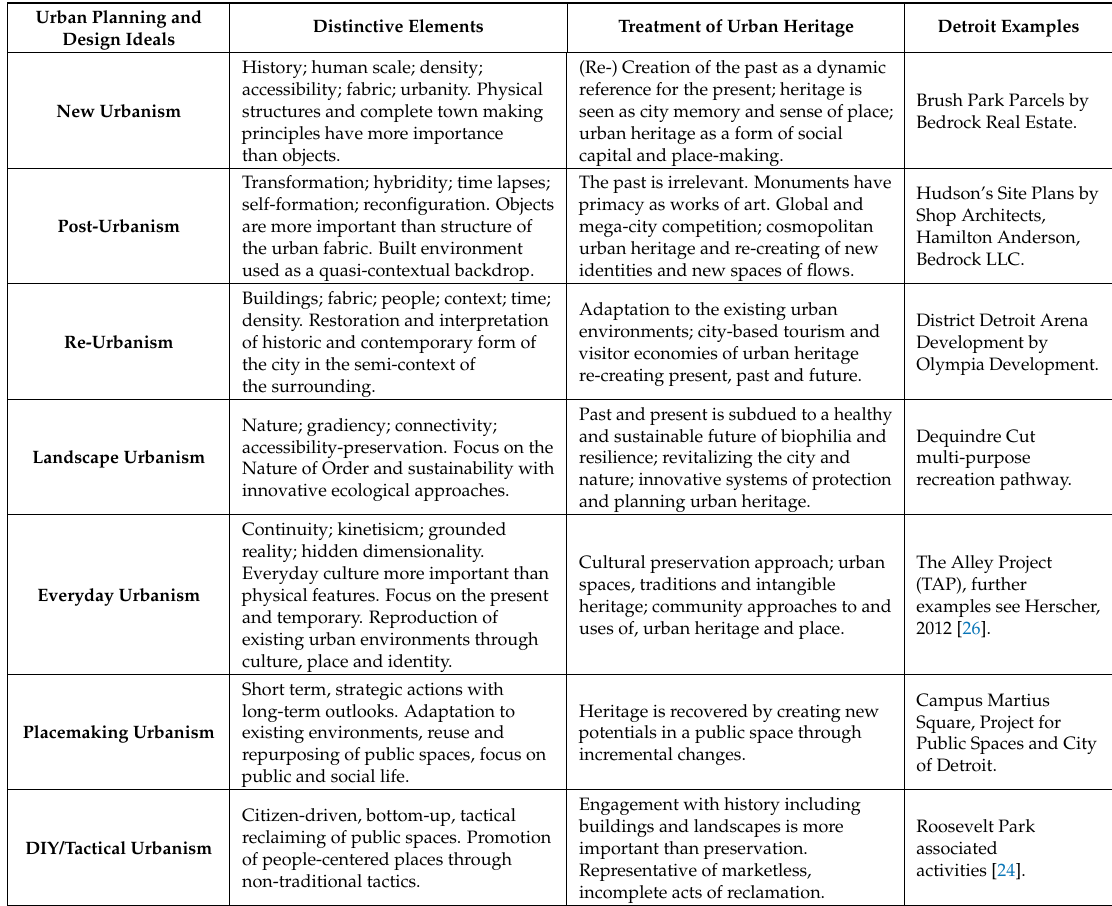
Table 1. Urban heritage in different urbanisms—urban planning and design